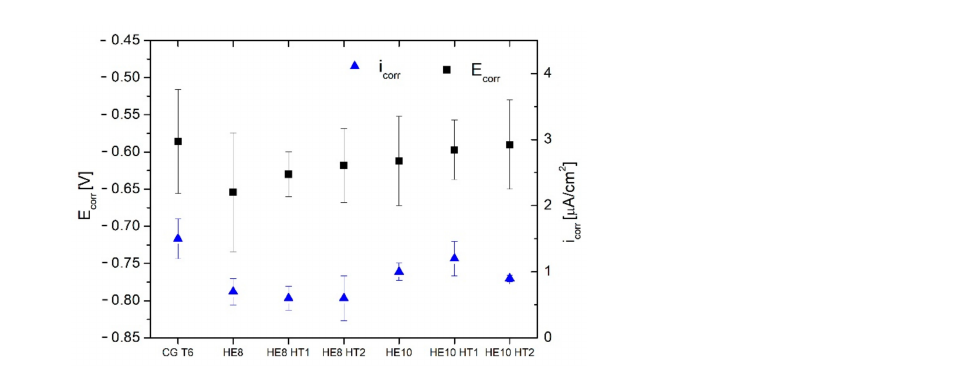
Figure 14. The electrochemical parameters E corr , E rep (left Y axis), and i corr (right Y axis) for each sample.